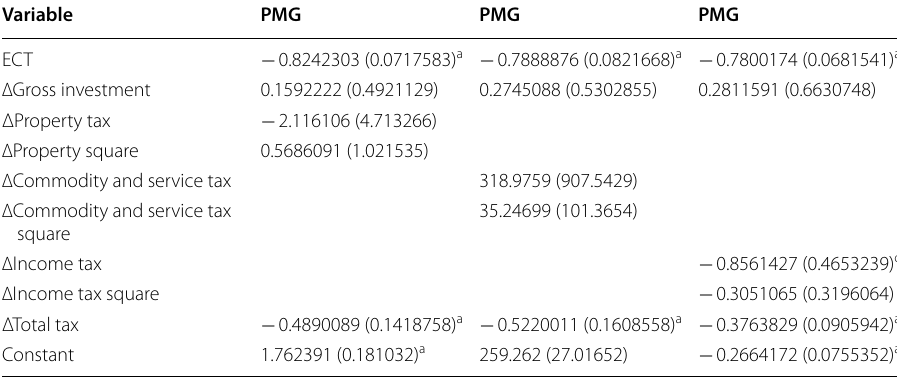
Table 5 Short-run coefficients with non-linear tax share Variable PMG